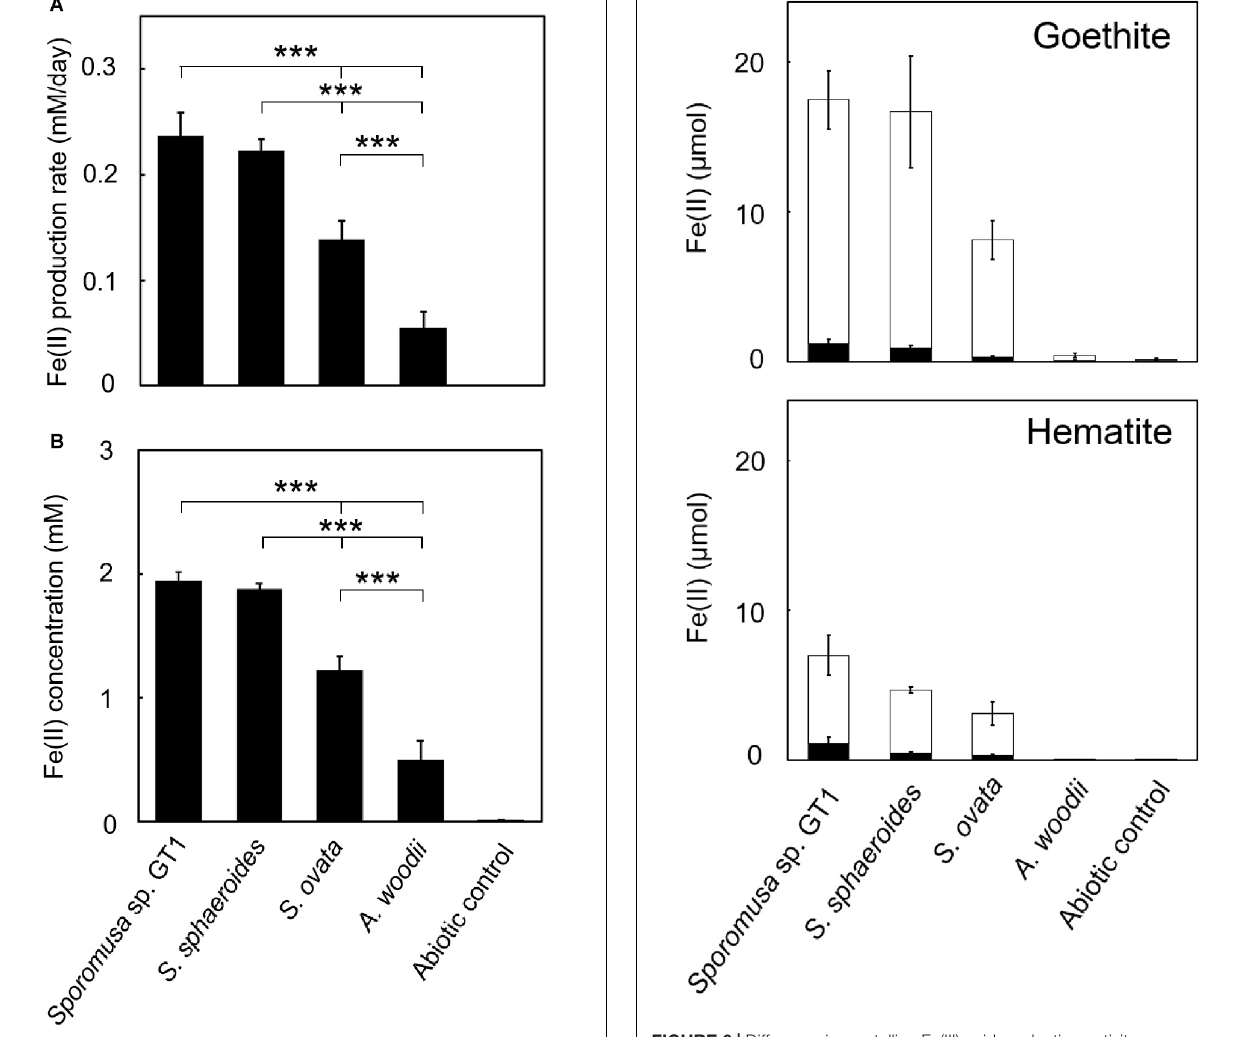
FIGURE 5 | Difference in HFO reduction activity among homoacetogens under lithotrophic growth conditions. Homoacetogens were cultivated on H 2 + CO 2 (80:20) in the presence of HFO. (A) Fe(II) production rate in the exponential phase. (B) Fe(II) accumulation in the stationary phase. Data are presented as the means of three independent cultures, and error bars represent standard deviations. *** p < 0.001, determined by one-way analysis of variance with Tukey’s honest significance difference test.